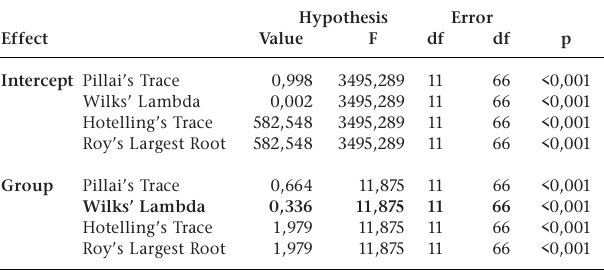
TABLE 4 M ANOVA : C OMPARISON OF THE VECTORS OF MEANS OF PILOTS AND NON - PILOTS IN RESPECT OF THE CHRONOMETRIC